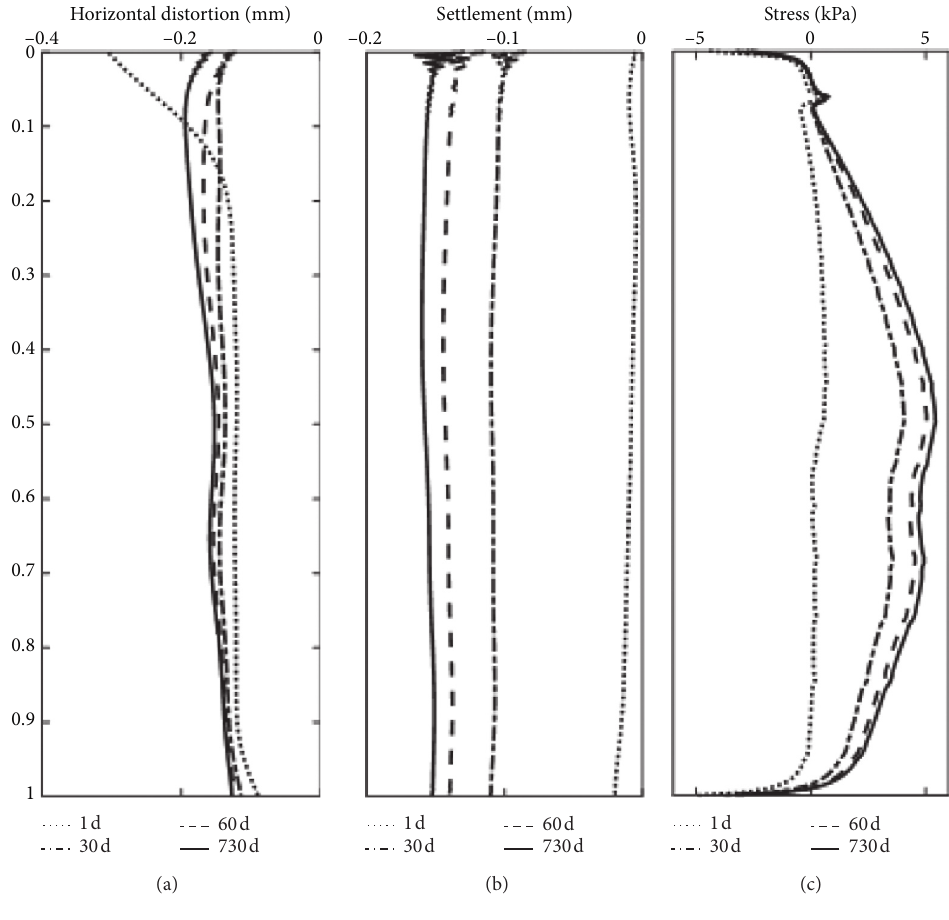
Figure 9: Pile (32m) simulation